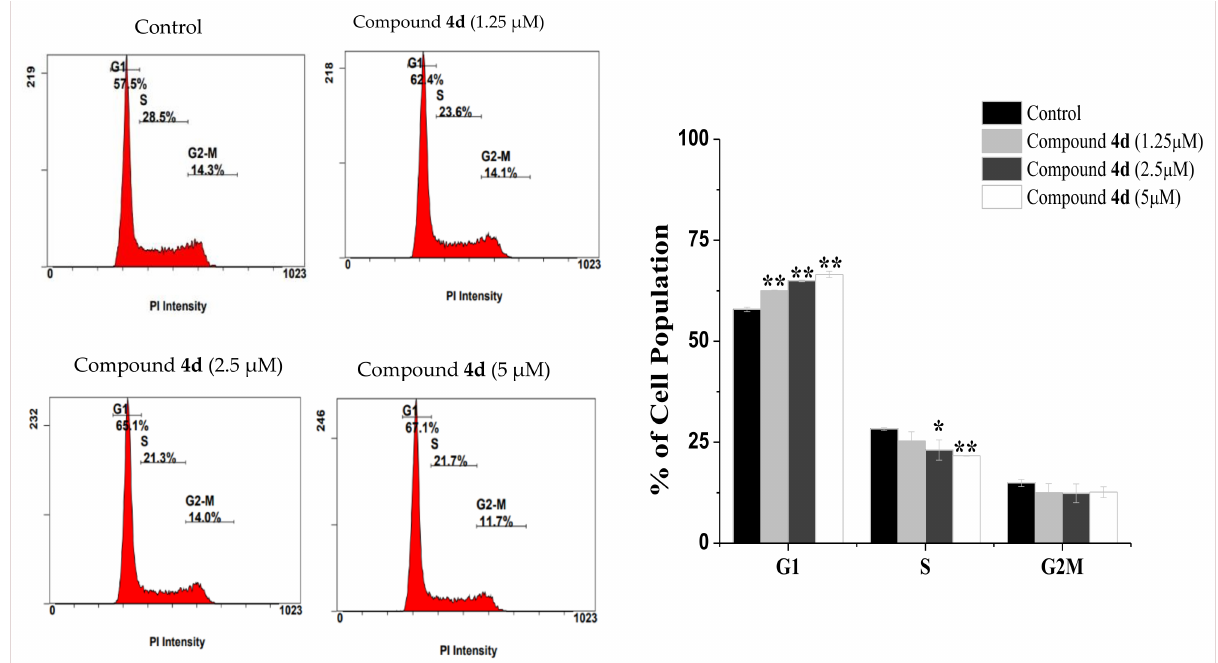
Figure 2. The effects of compound 4d on cell cycle distribution. MCF-7 cells untreated (control) or treated with the indicated concentrations of compound 4d for 24 h followed by staining with PI dye. Representative histograms (upper) and graph bar (down) showed the variation in the percentage of cells in each phase of the cell cycle. Results are presented as the mean ± SD. Differences between treated and control groups were considered statistically significant at p < 0.05 (*) and p < 0.01 (**).